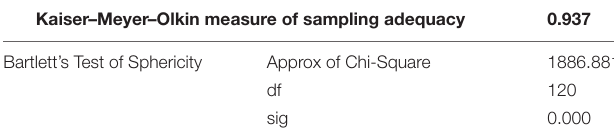
TABLE 2 | Kaiser–Meyer–Olkin and Bartlett’s Test of Sphericity. TABLE 3 | The common factor variance of 16